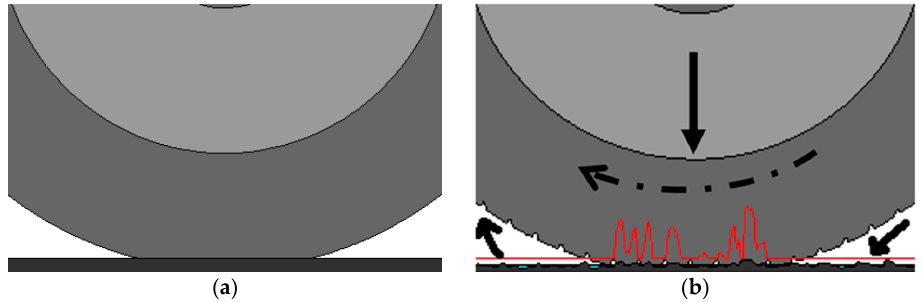
Figure 1. The two calculation steps. The first step determines the apparent contact area assuming the tire static on a smooth road ( a ). The second step determines the real contact area and thus the rolling resistance with the rolling tire upon the rough road surface ( b ).